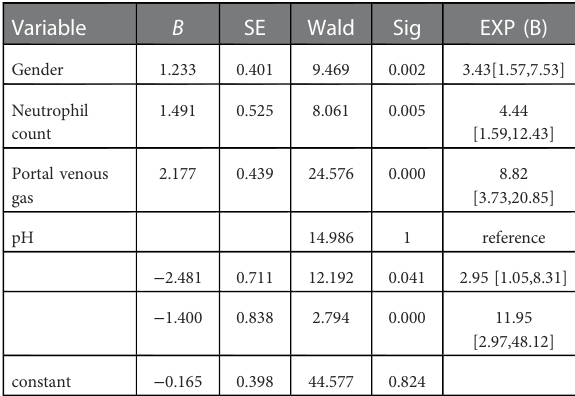
TABLE 4 Multivariate logistic regression for determining the effects of gender, neutrophil count, portal venous gas, and pH in predicting RP- NEC.